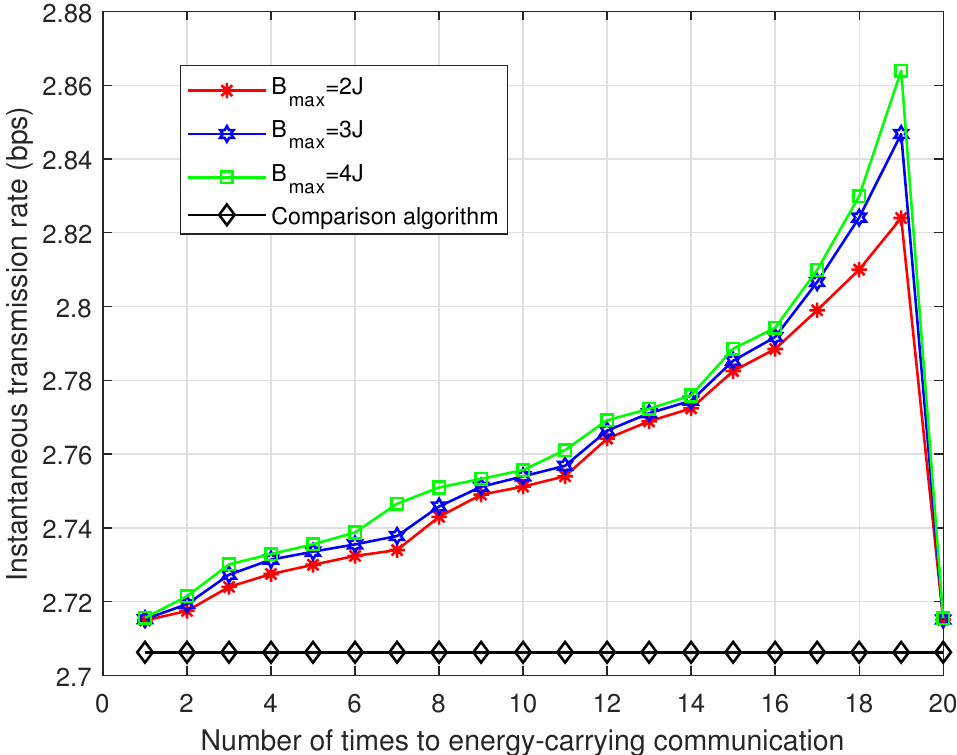
Figure 6. Comparison of the joint optimization algorithm and comparison algorithm under different relay energy storage